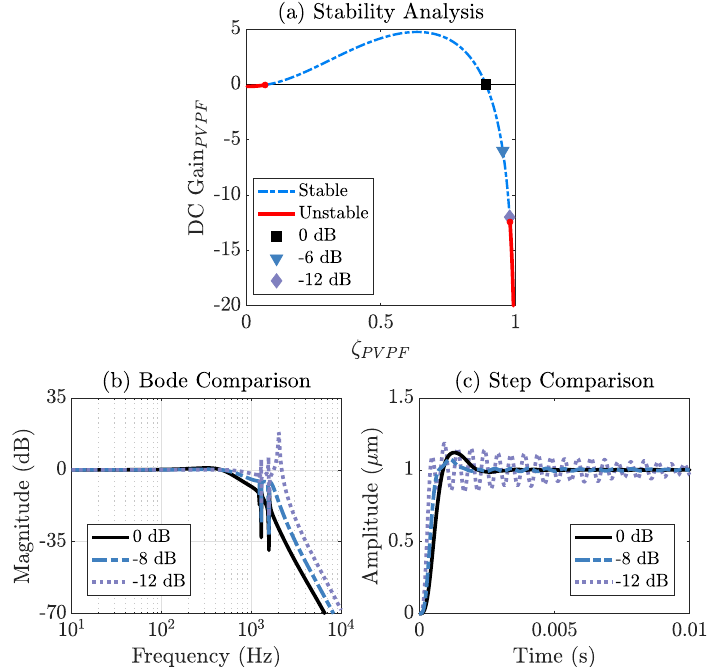
Figure 5. Figure 4a shows a graphical representation of the viable PVPF controllers when put in a closed–loop with a system. There exist three branches of stability, namely, Ξ 1 , Ξ 2 and Ξ 3 . Branch one, represented by a red solid line, exists such that two, represented by a blue dashed line, exists such that and lastly, branch three, represented by a red solid line, exists such that and is unstable. ( b , c ) shows the behaviours of the amplitude response and step responses of three key PVPF controllers found at 0dB, with the integral